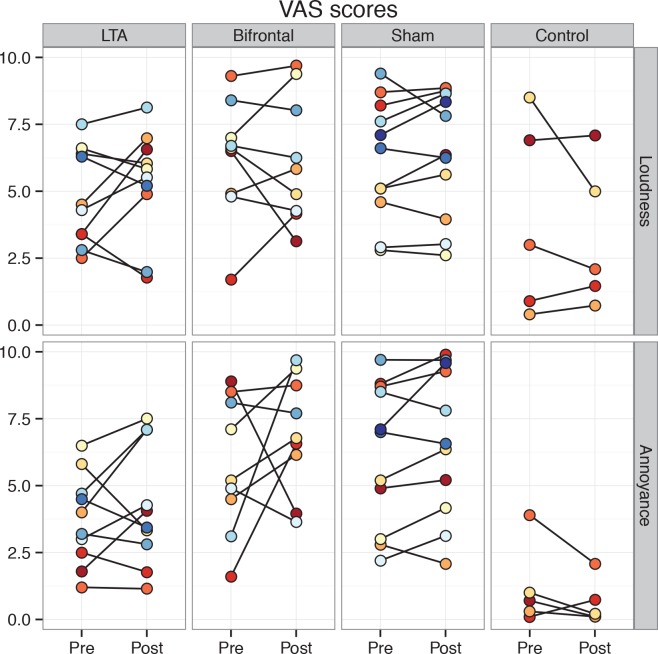
Individual VAS scores pre- and post-treatment shown group-wise.